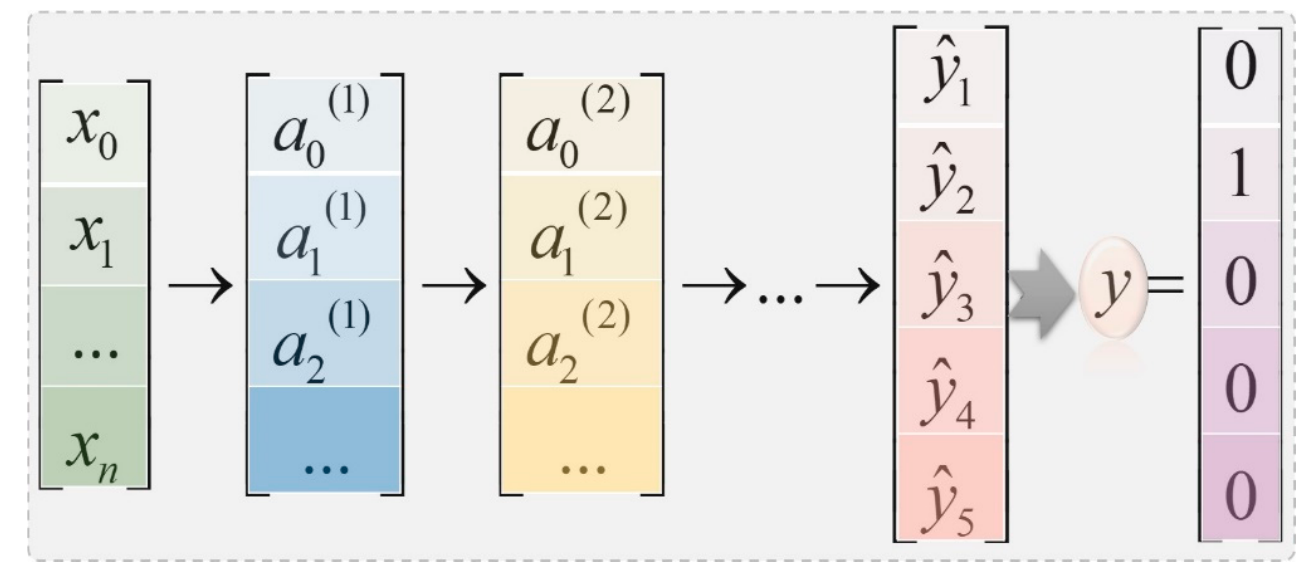
Figure 6. Schematic diagram of multi-category output.